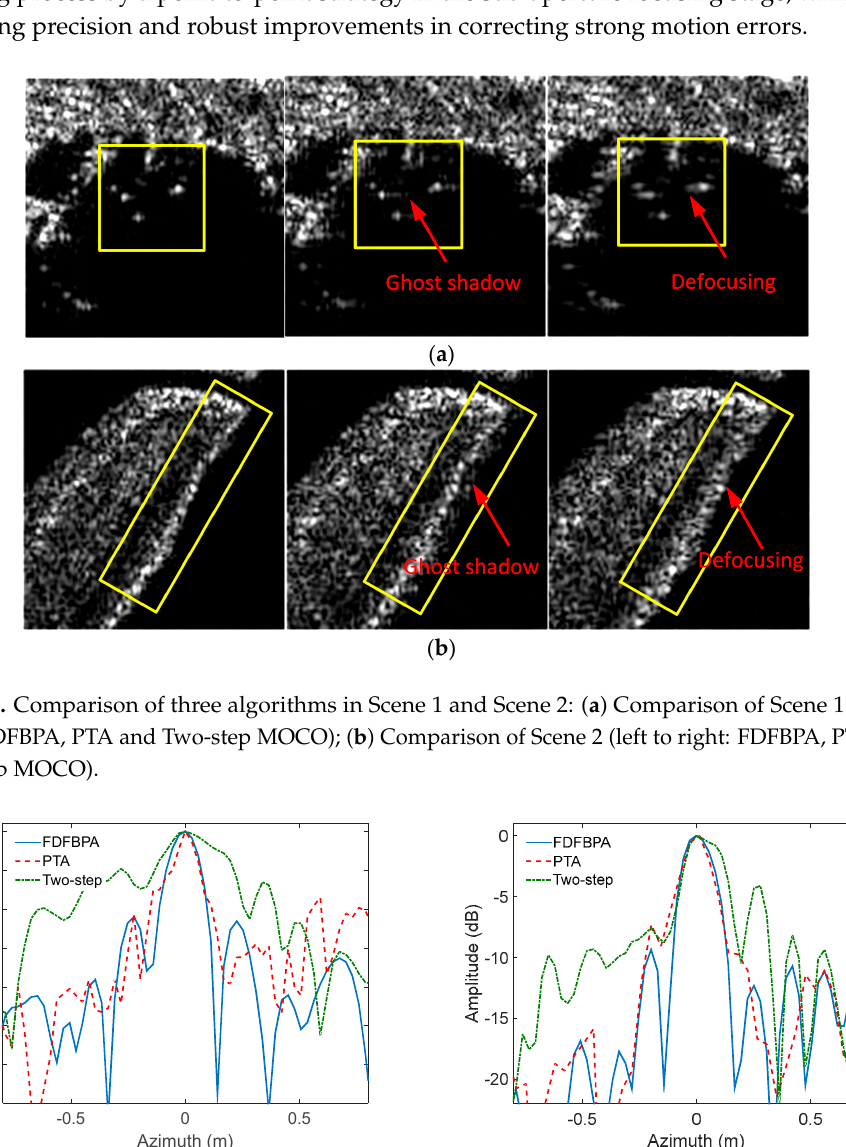
Figure 9. Azimuth pulse response curve comparison of FDFBPA, PTA and Two-step MOCO. ( a ) Scatter Point A; ( b ) Scatter Point B. Table 3. Comparison of Quantification Statistics